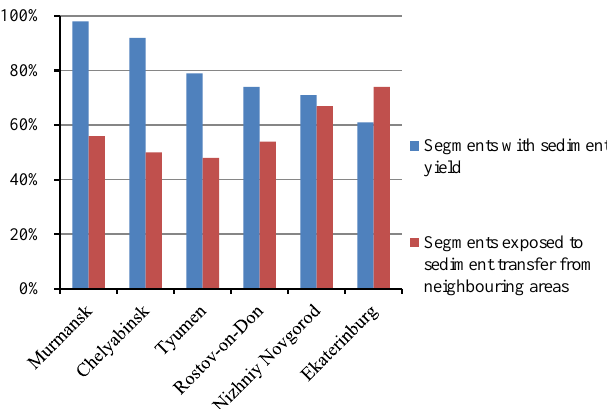
Figure 10. The proportions of site segments that were sources of sediment yield and the proportions of segments contaminated due to transfer from neighboring areas.